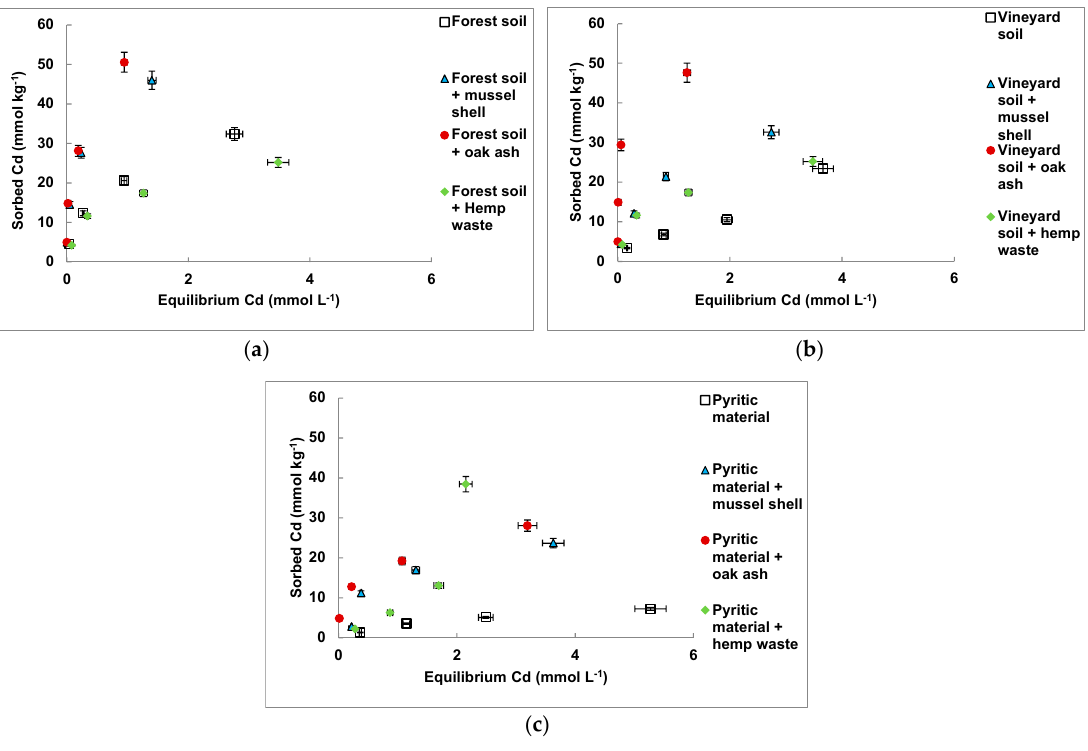
Figure 3. Cd sorption curves for the non-amended and amended forest soil ( a ), vineyard soil ( b ), and pyritic material ( c ). Average values (with error bars) for three replicates, with coefficients of variation always <5%.